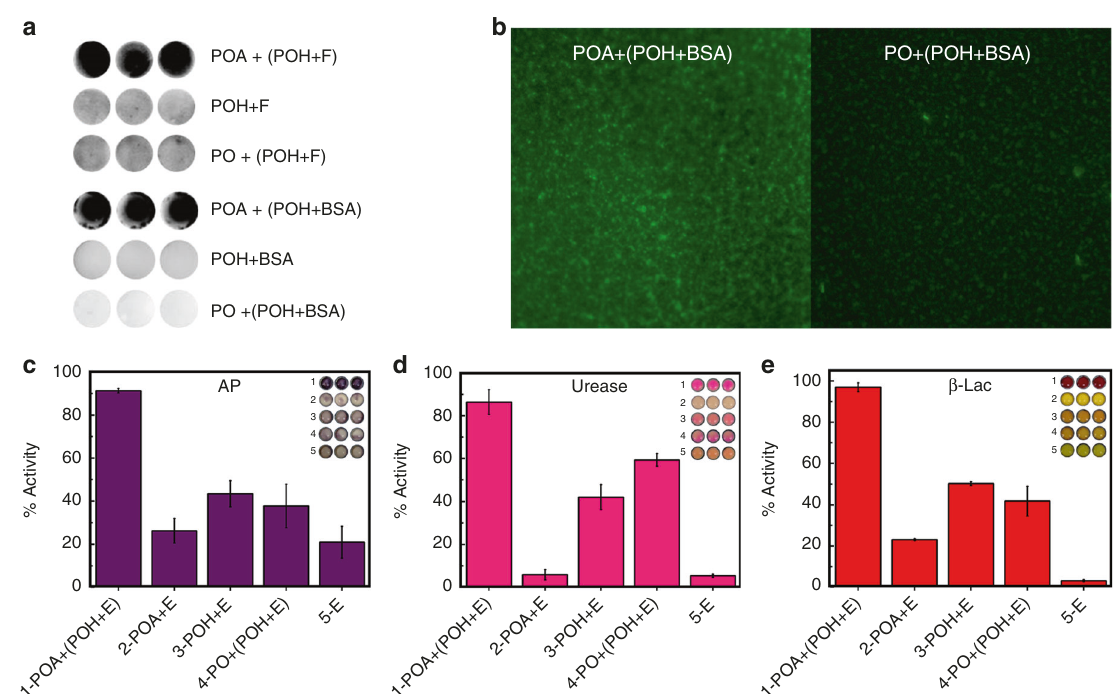
Fig. 2 Printed hydrogels can immobilize molecules of varying sizes. a Retention of fl uorescein (F, ~332 Da) printed in hydrogel (POA+(POH+F)) following washing in 0.1 M NaOH + 0.1% Tween 20 and fl uorescein isothiocyanate-labeled bovine serum albumin (FITC-BSA, ~66 kDa) printed in hydrogel (POA +(POH+BSA)) following washing in 10 mM PBS for 30 min. The high retained fl uorescence signal con fi rms the ef fi cacy of gel inks for protein immobilization. The three adjacent images in each series are replicates, con fi rming the reproducibility of the result. b FITC-BSA printed in a gelling ink (POA+POH) and a non-gelling ink (PO+POH) imaged by fl uorescence microscopy following washing in 10 mM PBS for 30 min (20× magni fi cation). c – e Residual activity of enzymes (E) following washing of samples in 10 mM PBS for 10 min, normalized relative to the corresponding unwashed control.